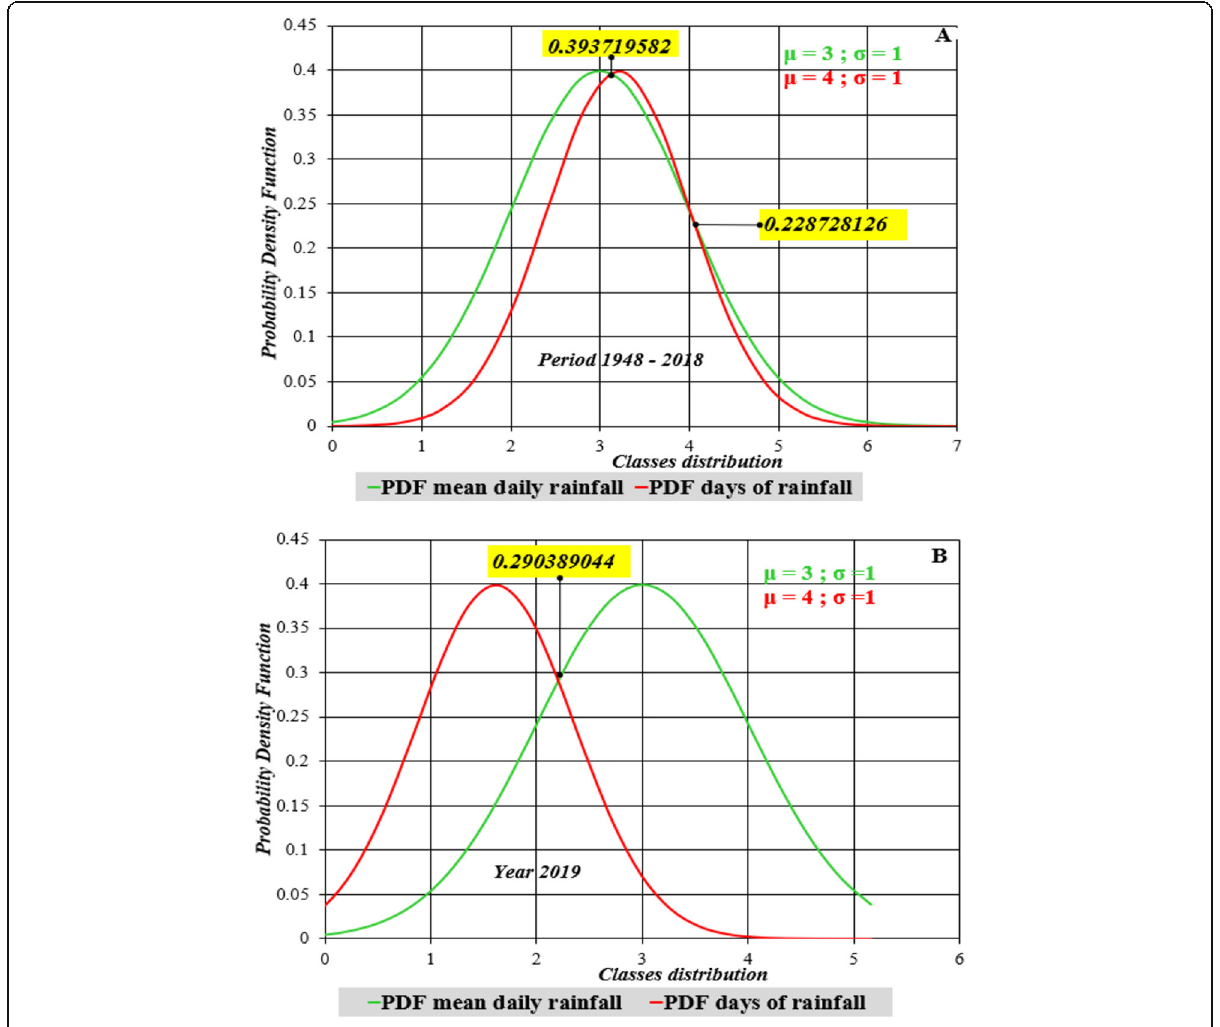
Fig. 8 Individual PDF curves and their intersections before ( A ) and in ( B )